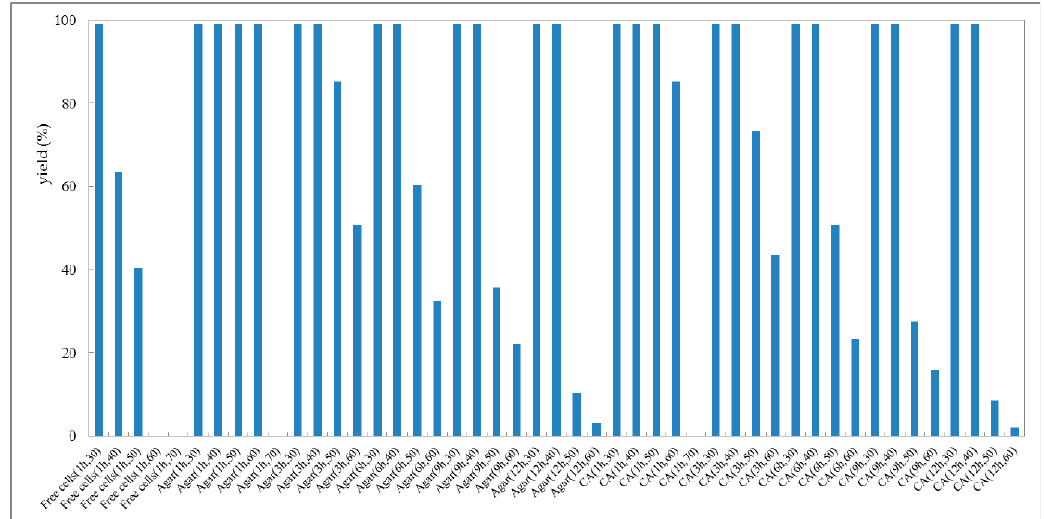
Figure 4. Thermostability of free cells and immobilized cells on agar and calcium alginate (CA) of G. candidum AS 2.361 catalyzing the reduction of 1-(2-bromophenyl) ethanone ( 1a ). Cells were incubated at different temperatures for different times before the substrate was added to initiate the reactions. Agar (1 h, 30) represents immobilized cells on the agar were incubated at 30 °C for 1 h before the substrate was added to initiate the reaction; CA (1 h, 30) represents immobilized cells on the calcium alginate were incubated at 30 °C for 1 h before the substrate was added to initiate the reaction.